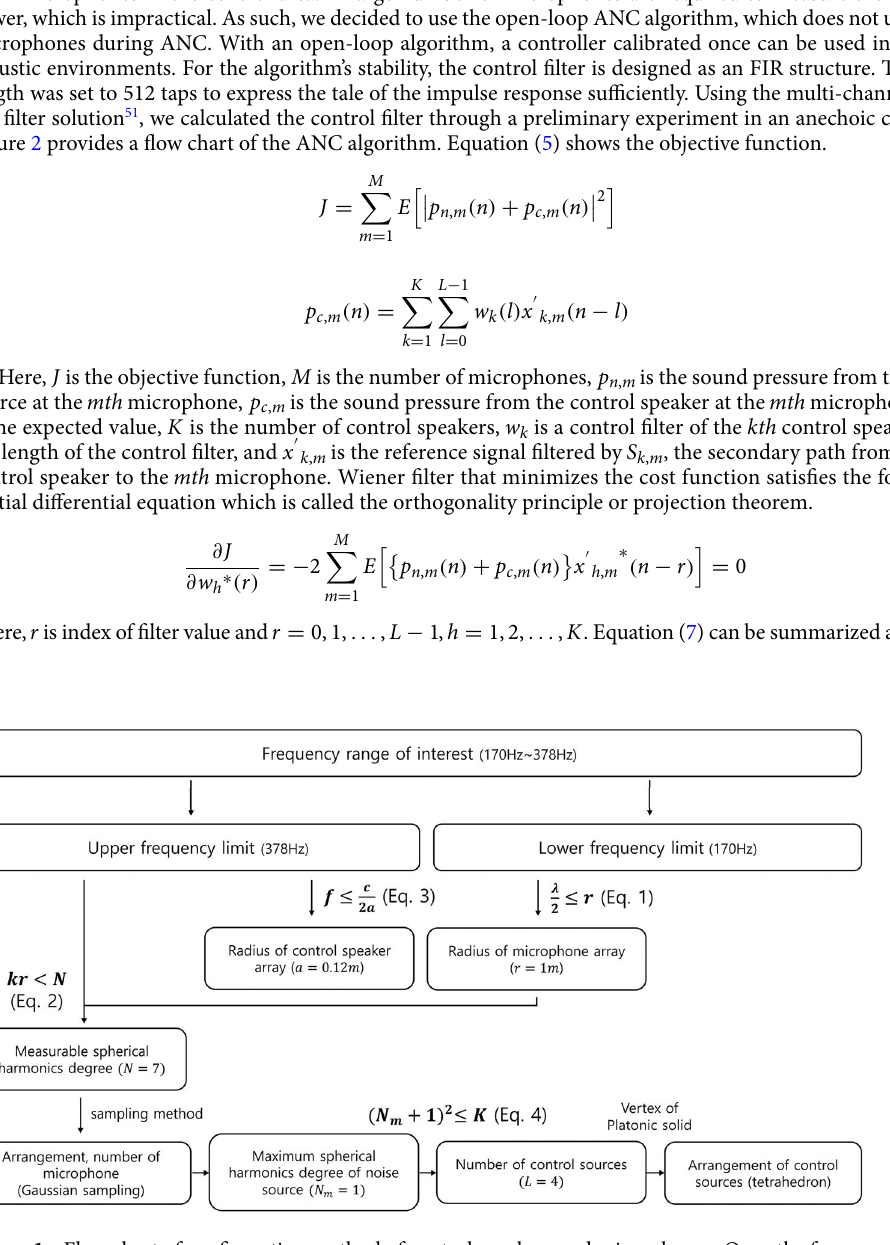
Figure 1. Flow chart of configuration method of control speakers and microphones. Once the frequency range of interest was determined by the spectrum of the noise source, the placement and number of control speakers and microphones can be determined according to the lower and upper frequency limits. Here, f is the frequency, c is the sound speed, a is the radius of the control speaker array, (cid:31) is the wavelength, r is the radius of the microphone array, k is the wavenumber, N is the measurable spherical harmonics degree, N m is the maximum spherical harmonics degree of the noise source, K is the number of control